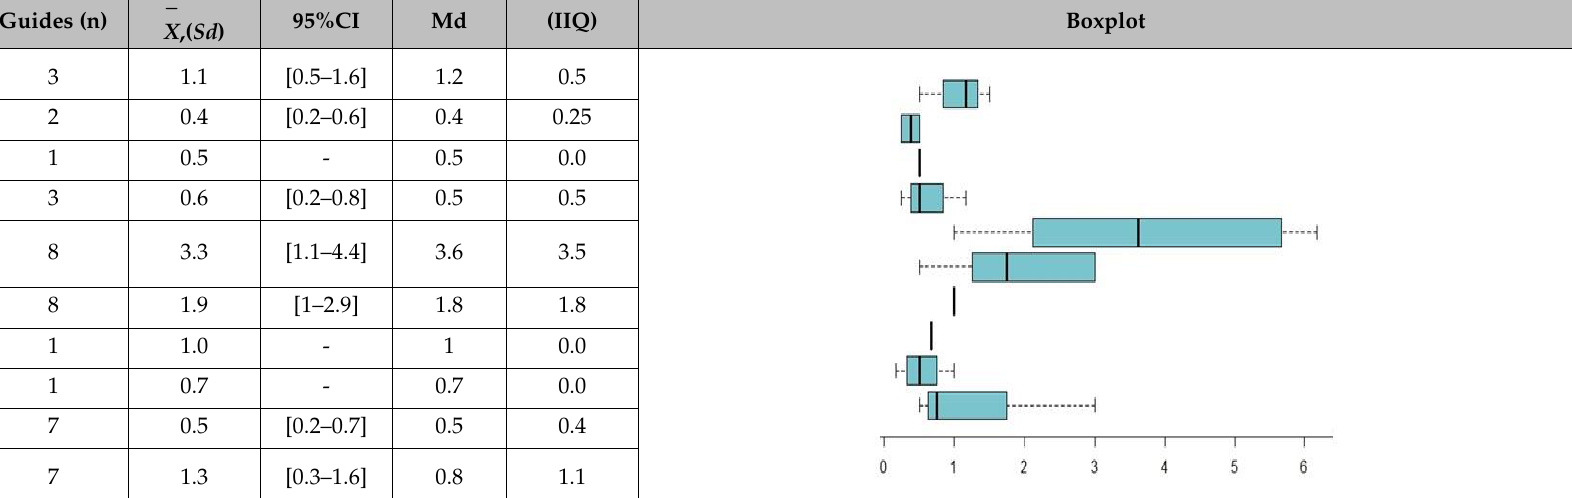
Table 3. Weekly frequency in the provision of controlled food groups as suggested by Autonomous Communities (CCAAs) for menu development by school food services in Spain.